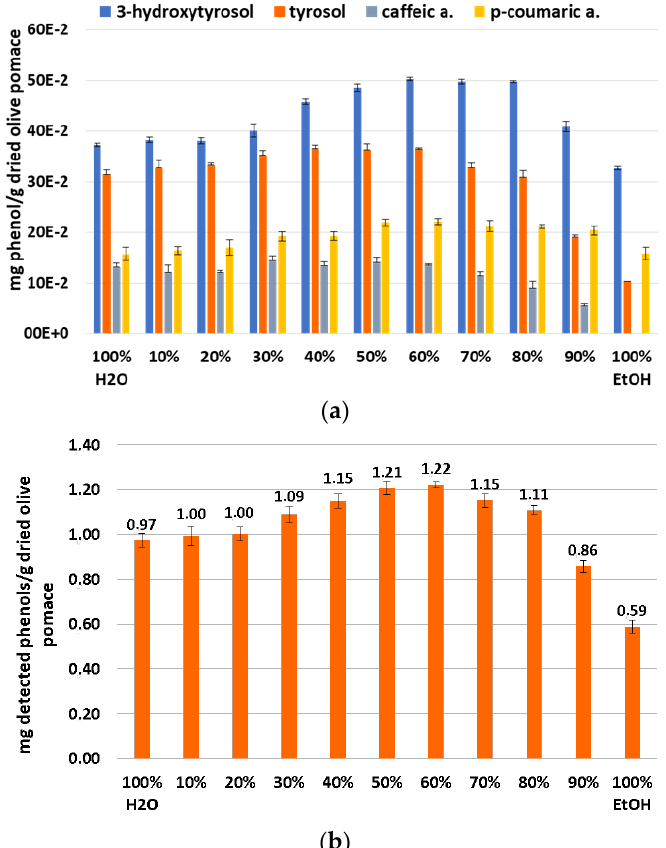
Figure 7. Determination of experimental solubilities at 50 °C of different ratios EtOH/H 2 O by UPLC, quantified phenols ( a ) and sum of quantified phenols ( b ).